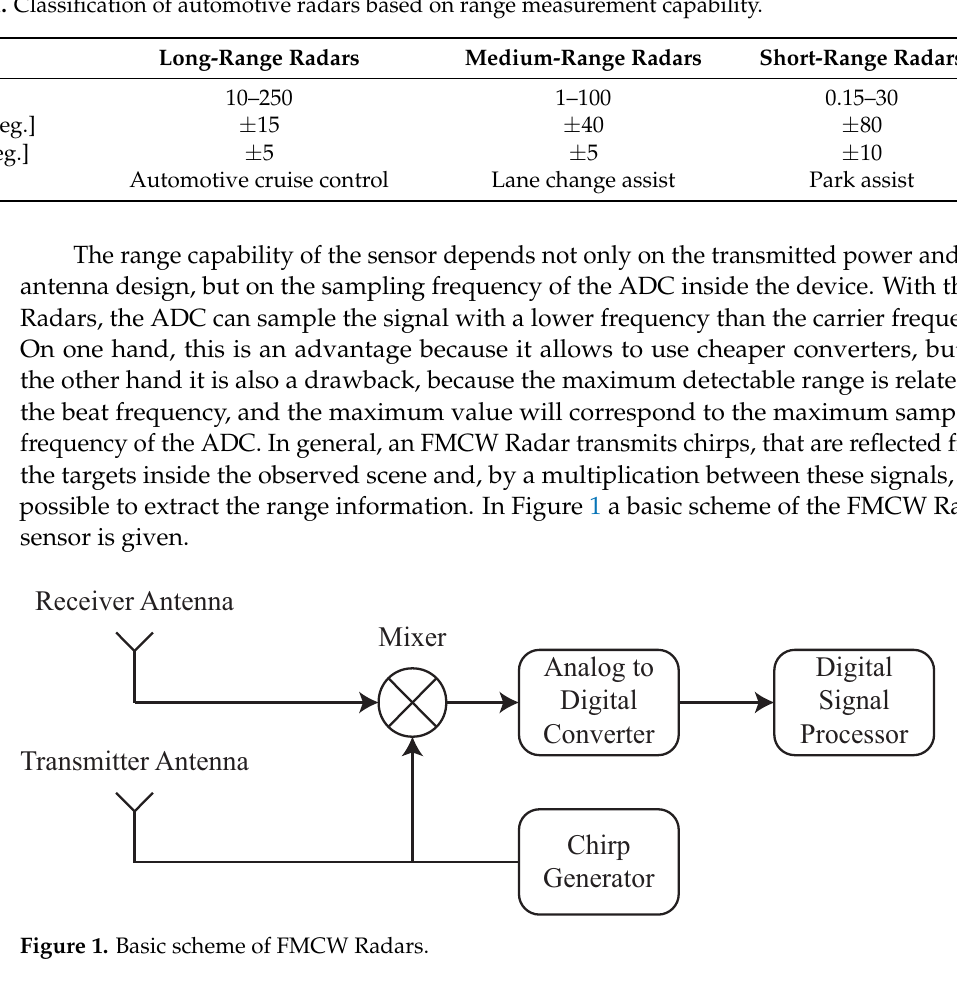
Table 1. Classification of automotive radars based on range measurement capability.